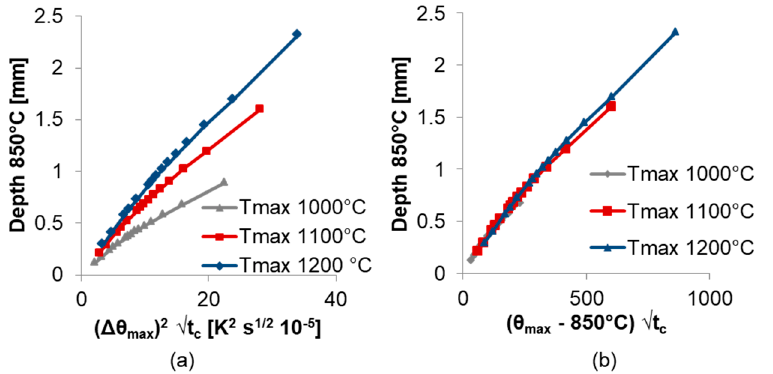
Figure 17. The depth of 850 ◦ C is reached for different maximal temperature at the surface, calculated by the analytic solution of a moving heat source, ( a ) plotted over the descriptive value ∆ θ 2 max √ t c . ( b ) plotted over the descriptive value ( Θ max − 850 ◦ C ) On the right hand side in Figure 17b a modified descriptive value is chosen: ( θ max – 850 °C) √ (t c ). By use of this parameter as load descriptive the depth of 850 °C depends not